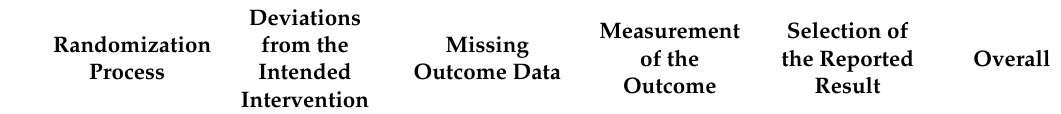
Table 6. Version 2 of the Cochrane risk-of-bias tool (RoB2) for randomized controlled trials included in the systematic